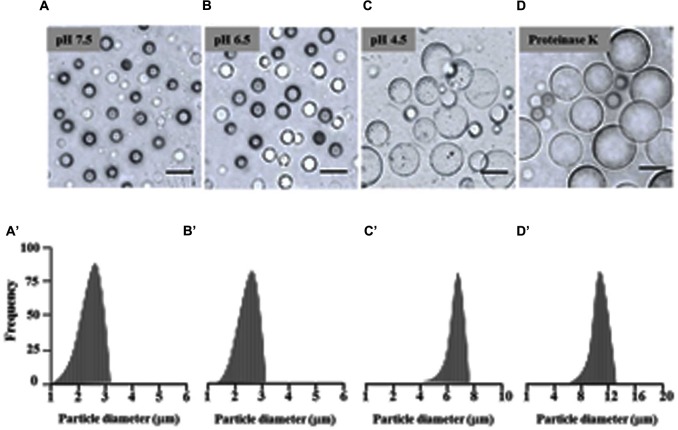
Effects of pH and proteinase treatment on the aggregation/coalescence of date palm LDs. Aggregation and coalescence of LDs as a function of pH was performed by suspending isolated LDs in buffer B (see Materials and Methods) at various pH 2.5, 3.5, 4.5, 5.5, 6.5, and 7.5 and immediately analyzed under light microscope or after an incubation for 12 h at room temperature. (A–D) Representative light micrographs of LDs suspended in pH 7.5, 6.5, 4.5 or after proteinase treatment, respectively. Images were obtained at a magnification of 40×. Bar represents 5 mm. (A’–D’) Size distributions (% frequency) of LDs in the different media at the indicated pH were determined using a laser granulometer as described in Section “Materials and Methods.”